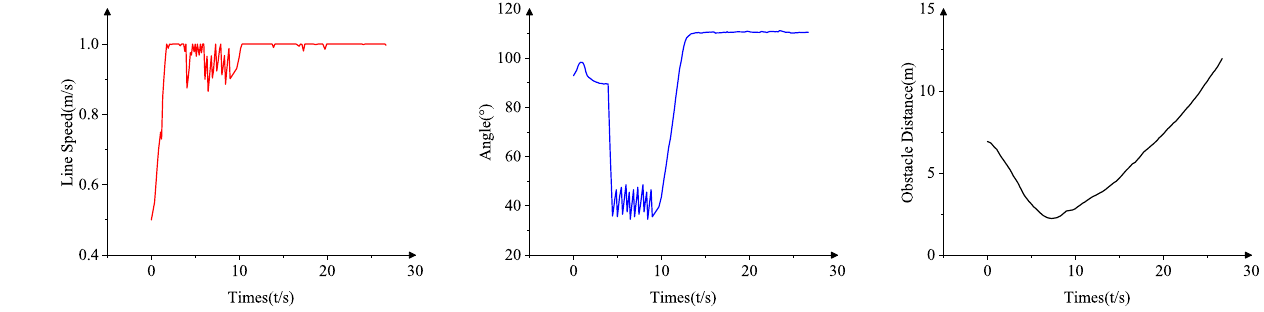
Figure 16. Head-on situation for the improvement of the PSO-based search method.